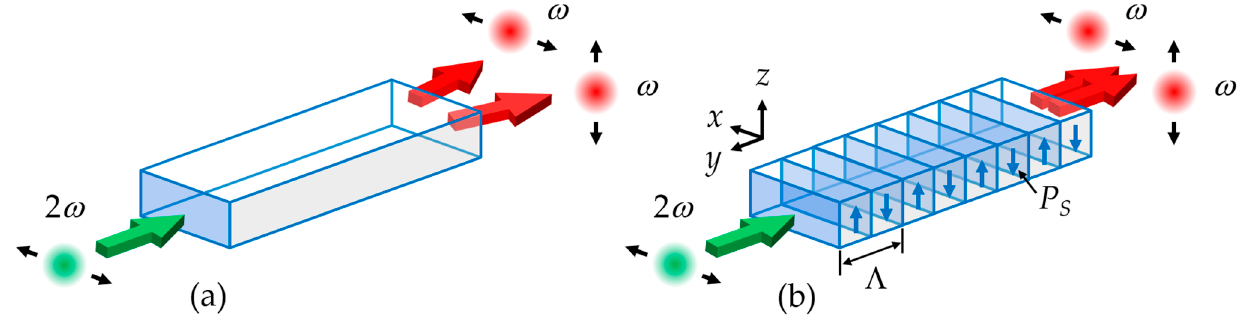
Figure 1. Schematic diagrams showing the frequency and polarization relationships of pump, signal, and idler photons interacting via Type II spontaneous parametric down-conversion (SPDC) in ( a ) a non-poled lithium niobate (LN) and ( b ) a periodically poled LN (PPLN).